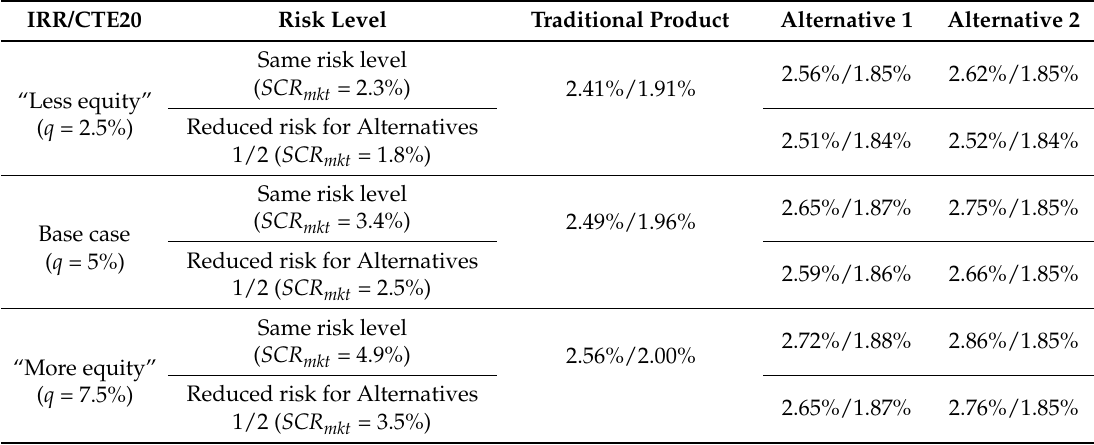
Table 5. IRR and CTE20 for products with the same SCR mkt , and with reduced SCR mkt for alternative products, for base case and sensitivities of asset